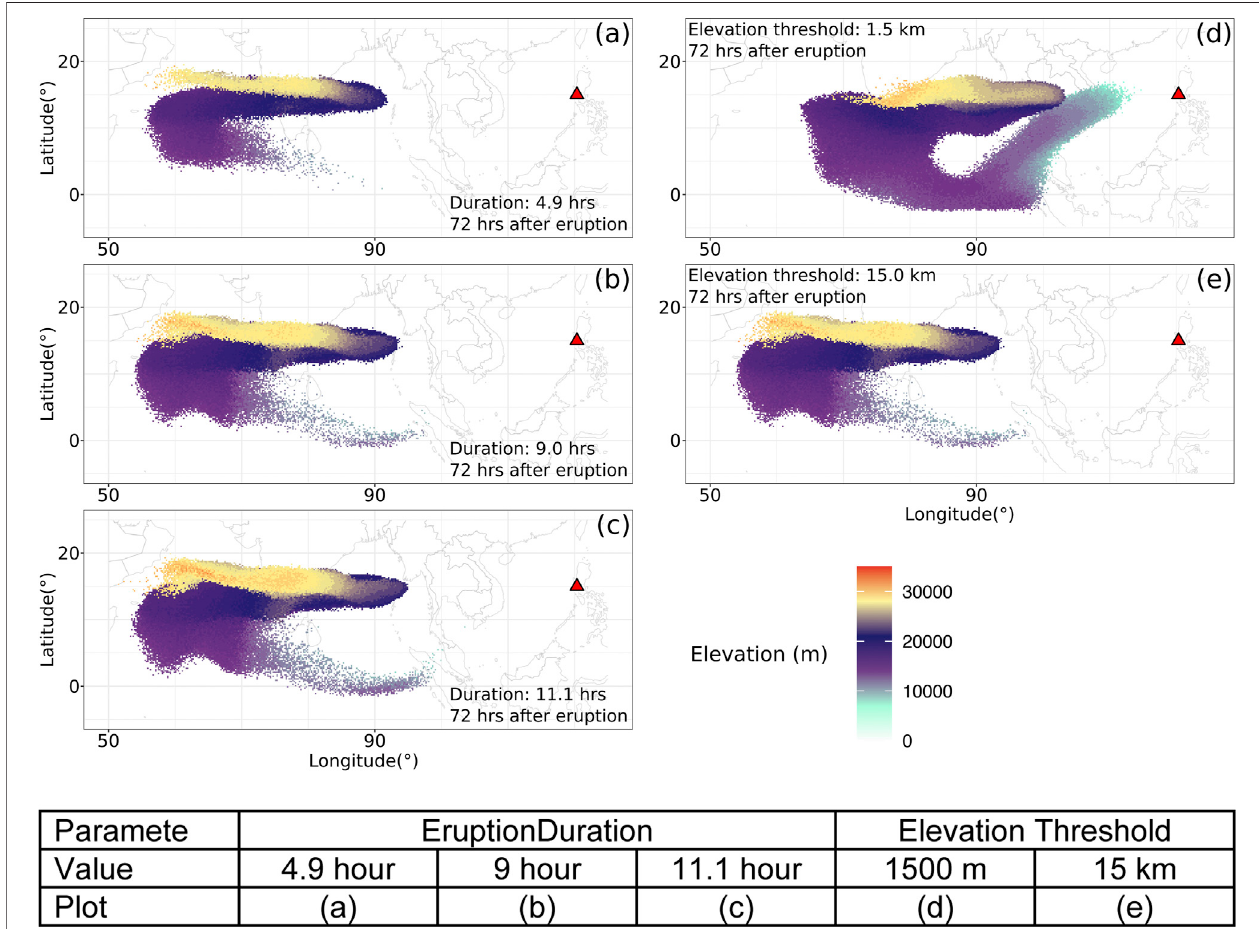
FIGURE12| SensitivityofPuffsimulationwithrespecttoeruptiondurationsandinitialashcloudcutoffheights(elevationthreshold).Fordifferenteruptiondurations, the starting and ending time for each case are in Table 3 . The contours correspond to ash concentration at 72 h after eruption. Details are in the table.